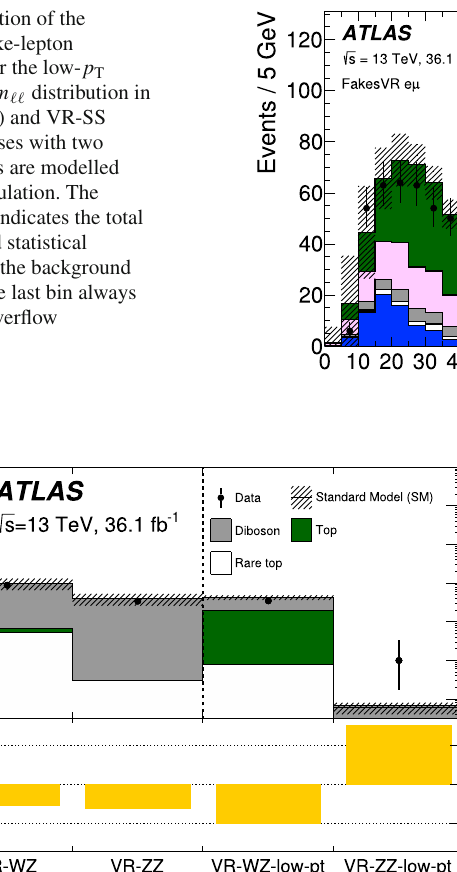
Fig. 8 The observed and expected yields in the diboson VRs. The data are compared to the sum of the expected backgrounds. The observed deviation from the expected yield normalised to the total uncertainty is shown in the bottom panel. The hatched uncertainty band includes